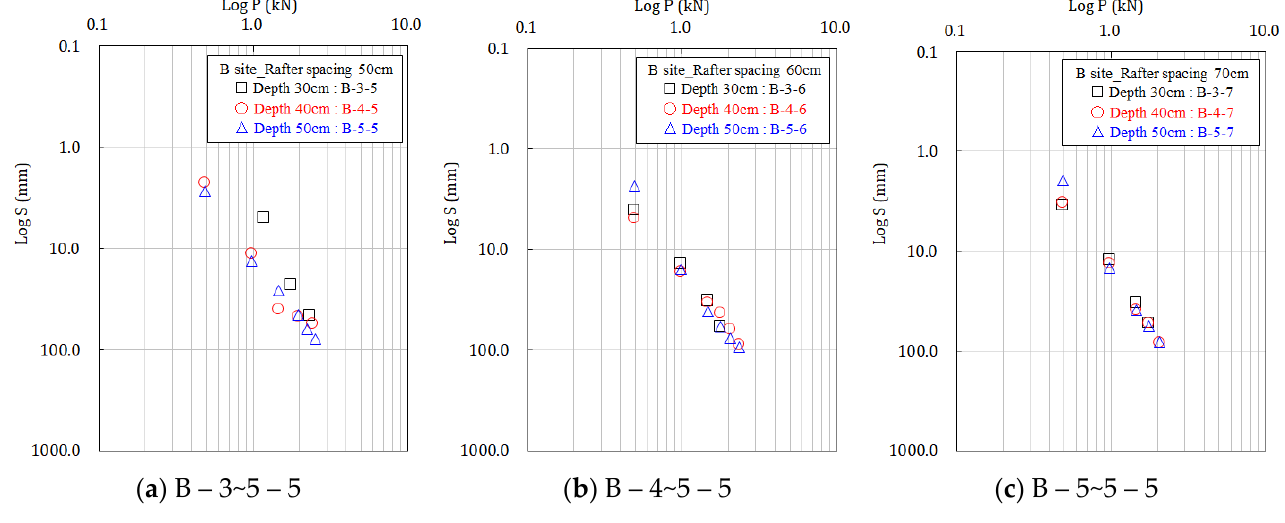
Figure 10. Results of field uplift resistance on site B.